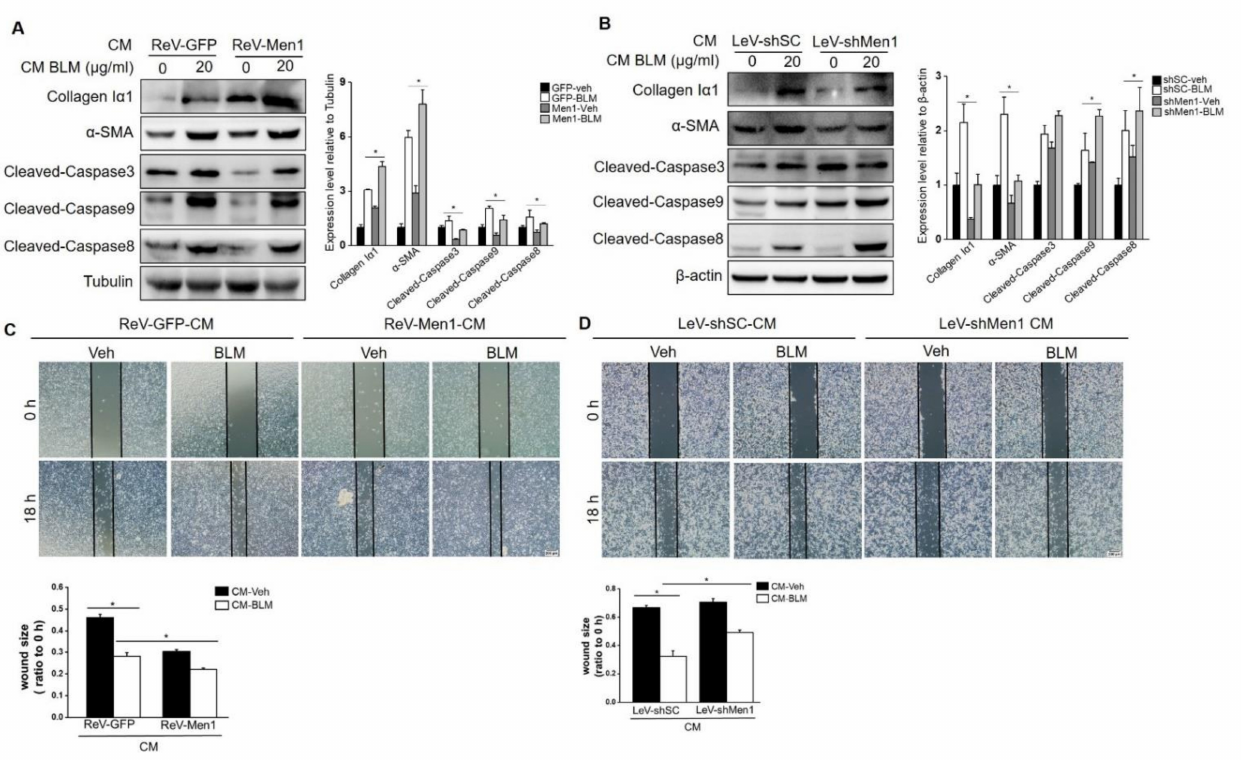
Figure 6. Men1 in macrophages promotes MEF to the profibrotic phenotype. ( A , B ) Cell media (CM) from Men1 overexpressing or Men1 knockdown Raw264.7 cells with or without BLM treatment were added to MEF, and the protein levels of collagen I α 1, α -SMA, and cleaved Caspase3, 9, 8 were detected by Western blotting. Blots in two repeated experiments were analyzed by Image J software. ( C , D ) MEFs were plated into 12 − well plates, and a scratch was made by a 100 µ L sterile pipette tip. CM from Raw264.7 cells was added to MEF continuous culture. A total of three images for each group were photographed by an optical microscope, and the wound size from three repeated experiments was analyzed by Image J software. Scale bar: 200 µ m. * p <